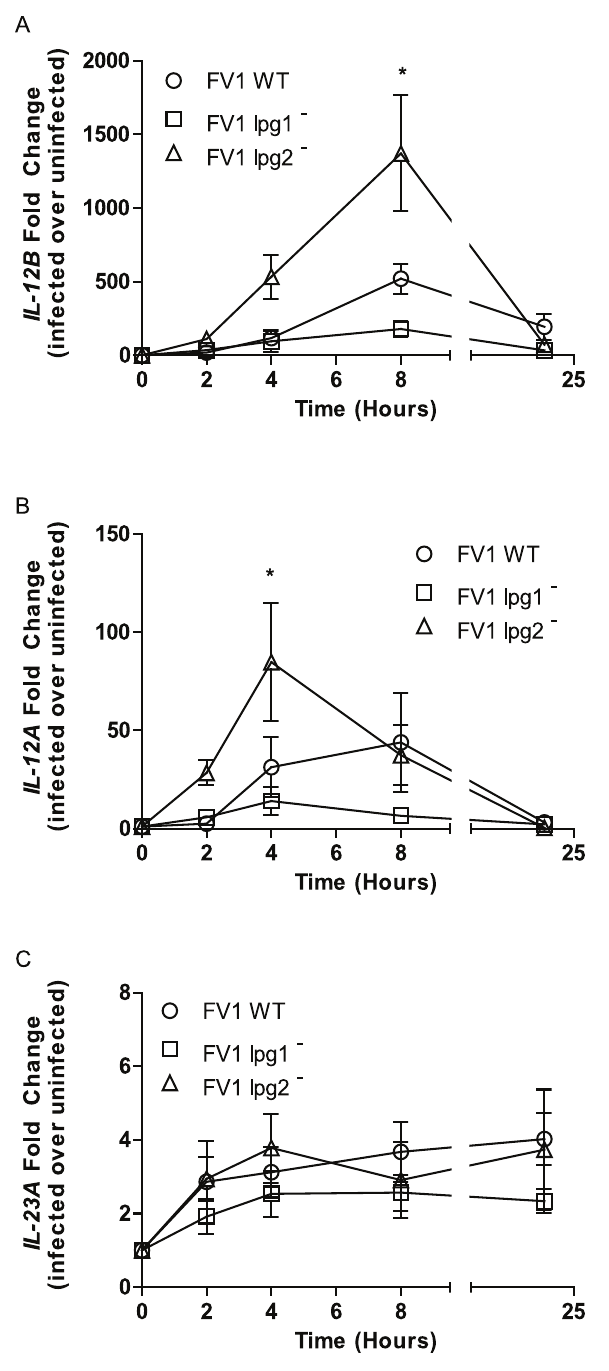
Fig 3. Kinetic analysis of IL12 and IL23 expression modulation by L . major LPG and PG null mutants. Human DCs (n = 3 donors) were infected with L . major FV1 parasites: L . major FV1 (WT), LPG null mutant (FV1 lpg1 − ), LPG add back (FV1 lpg1 − /+ LPG1 ), PG null mutant (FV1 lpg2 − ), or PG add back (FV1 lpg2 − /+ LPG2 ). At 2, 4, 8, and 24 hours post infection, IL12B ( A ), IL12A (B), and IL23A (C) expression was measured by qRT-PCR. Fold changes were calculated using the ΔΔ C T method and are represented as fold change over uninfected samples. Mean values of individual donors ± SD are presented. Statistical significance p < 0.05, ANOVA with Bonferroni multiple comparisons